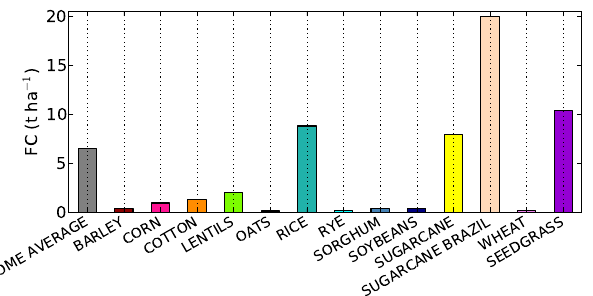
Figure 6. Fuel consumption (FC) for different US crop types as reported by McCarty et al. (2011), and Brazilian sugarcane (Lara et al., 2005). The grey bar corresponds to the biome-averaged FC value for crop residue burning as presented in this